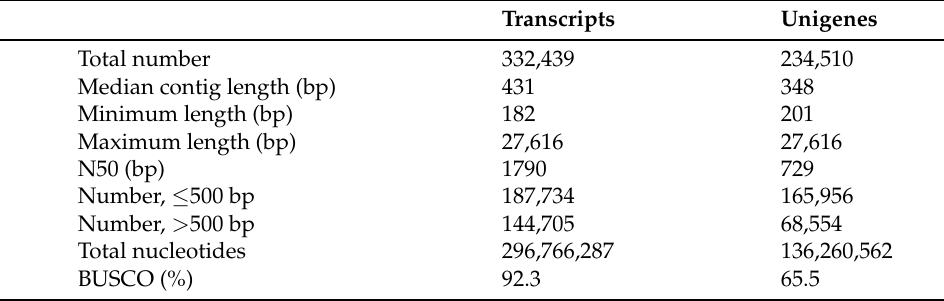
Table 2. Overview of the de novo transcriptome